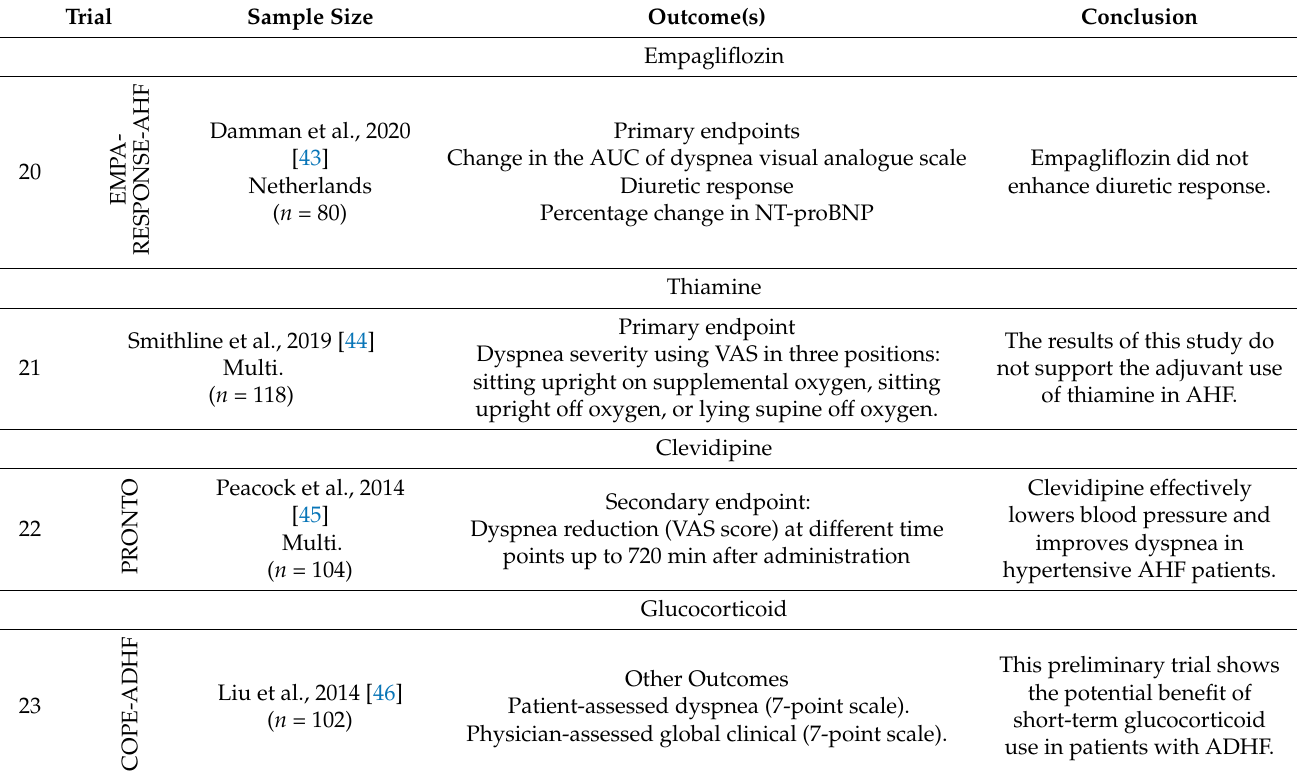
Table 3. Summary of studies investigated miscellaneous